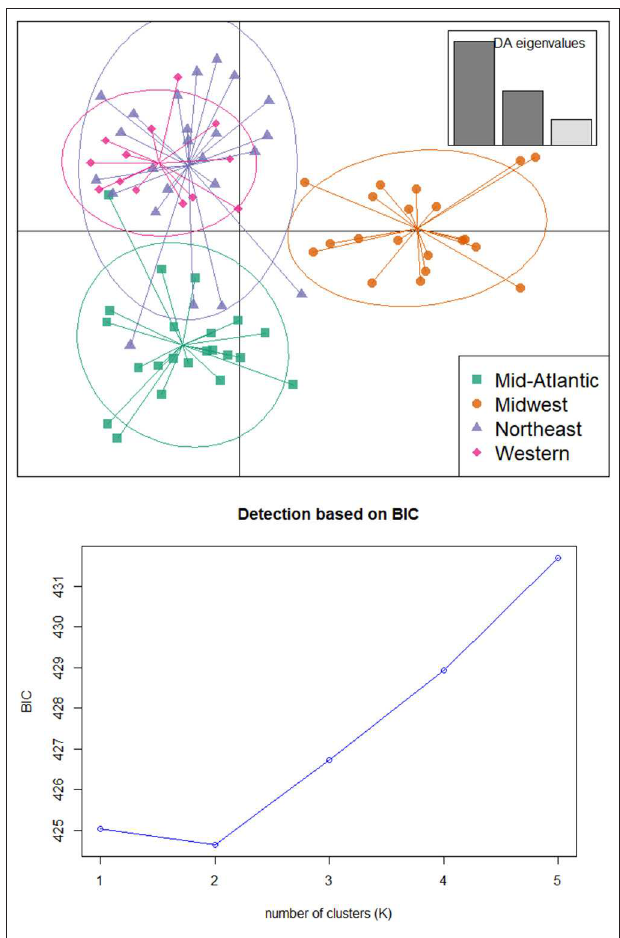
FIGURE 5 | (Top) Discriminant Analysis of Principle Components (DAPC) of Tetramorium immigrans SNPs data, grouped by geographic region. (Bottom) Optimal number of clusters based on k-means using find.clusters in adegenet